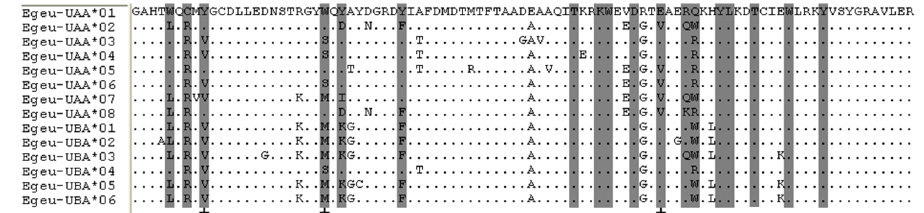
Fig 3. Alignment of translated amino acid sequences for exon 3 of MHC class I genes in the Chinese egret. A total of 14 allelesfrom two loci are shown. Dots indicateidentity to the majority rule consensus sequence.Codonscorresponding to PBR residues in humanHLA-A2 are shaded [33, 34]. The presumed sites that positive selectionis acting upon are indicatedby plus sign (on alignment bottom).